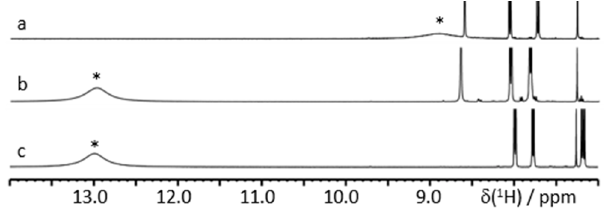
Figure 8. Characteristic 1 H NMR spectra of 3 and 4 in CDCl 3 at 300 K in the presence of Et 3 N. The signals of OH-protons are marked by asterisks. The mole fractions are ( a ) water: 4 :Et 3 N = 1:1.2:35, ( b ) water: 4 :Et 3 N = 1:8.7:35, and ( c ) water: 3 :Et 3 N =